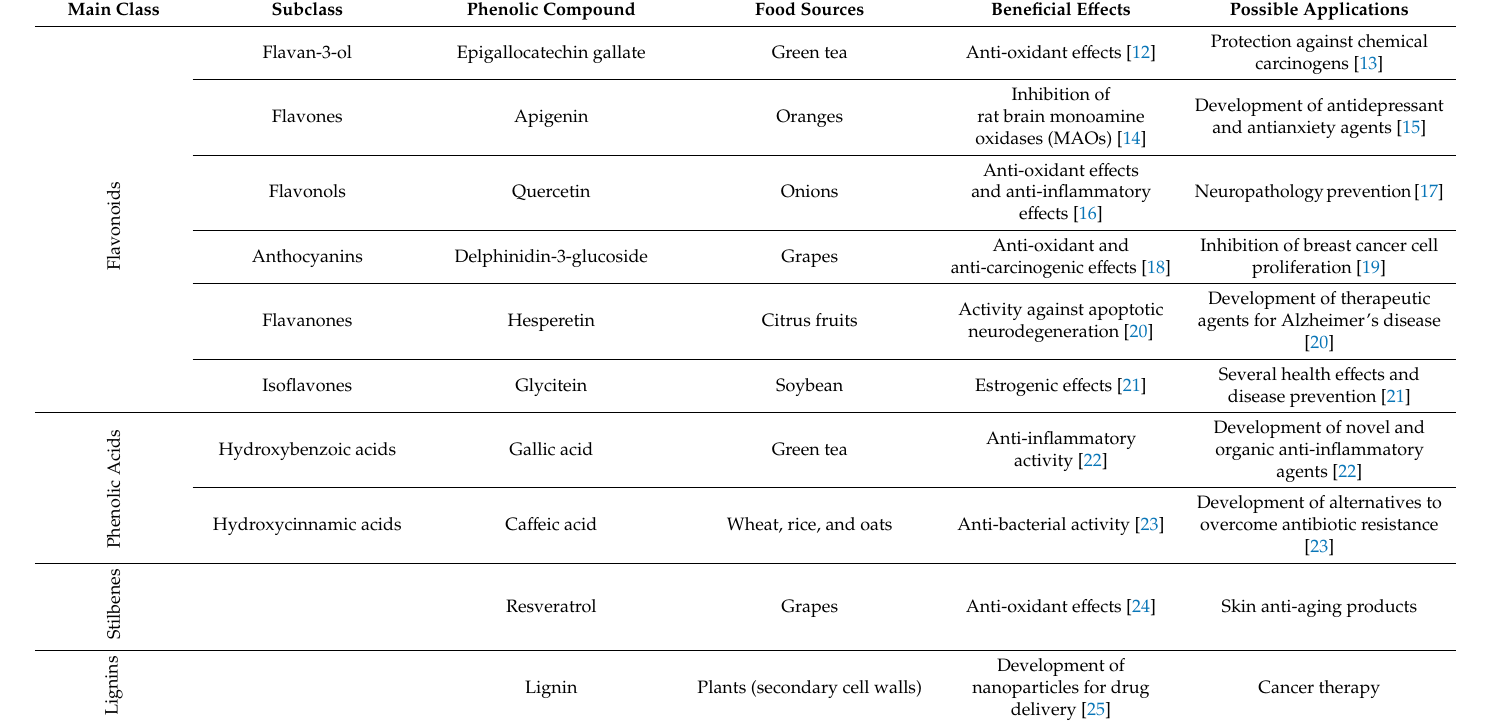
Table 1. Examples of phenolic compounds, food sources, applications, and beneficial e ff